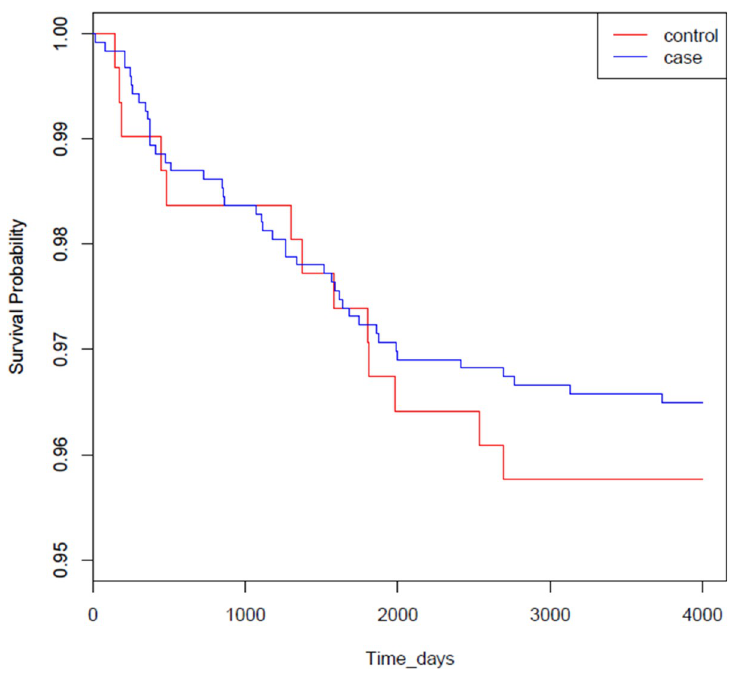
Fig 1. Kaplan–Meier curves of freedom from ischemic stroke between patients with Behc¸et’s Disease (BD) and the comparisons without. Group 1, patients with BD; group 2, control subjects without BD. The difference between the two curves is statistically significant (log-rank test, p <